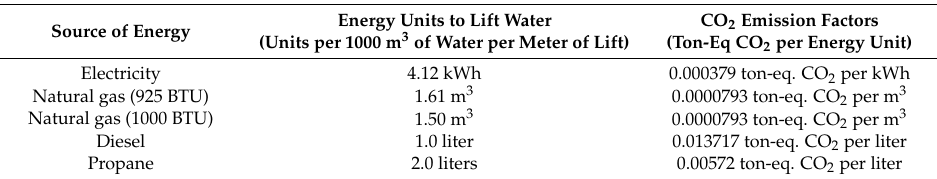
Table 2. Units of the different energy sources required to lift water and CO 2 emission